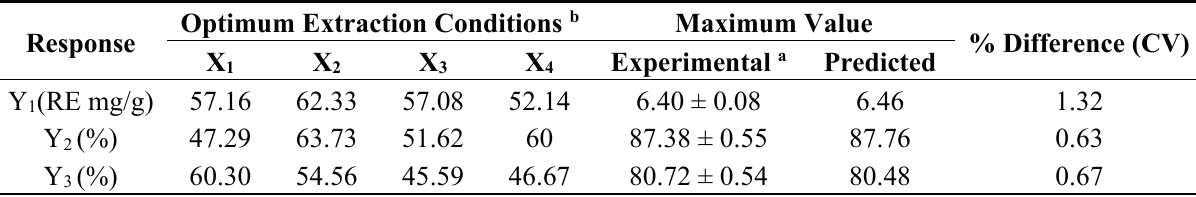
Table 5. Experimental and predicted values of response variables on optimal conditions.